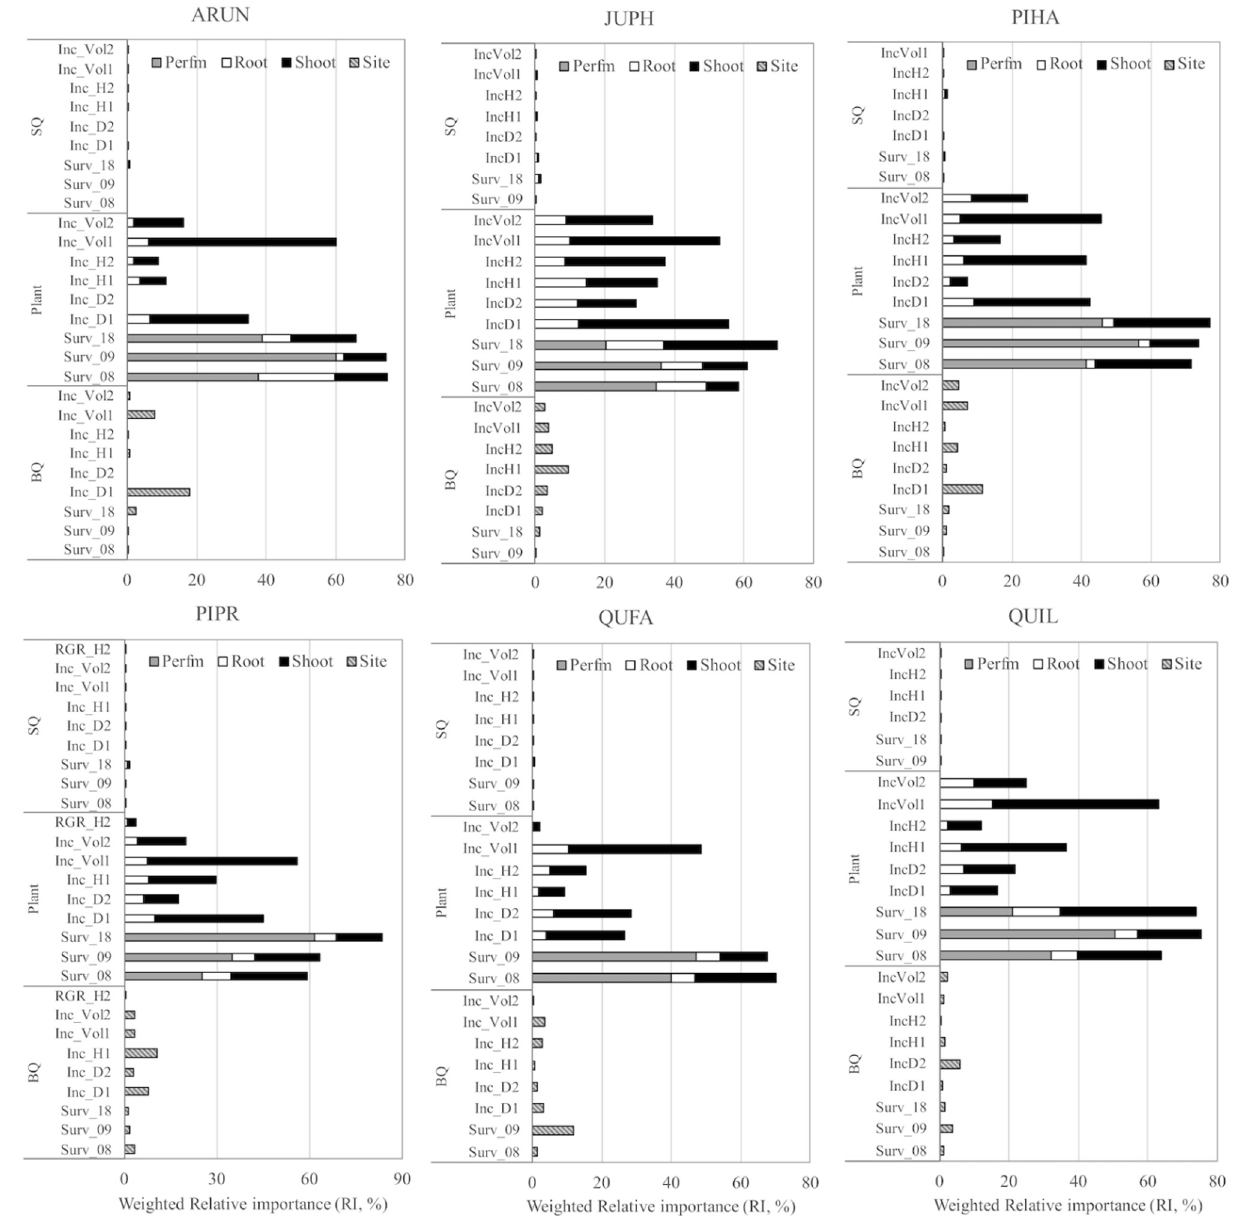
Figure 5. Relative importance (RI, %, obtained from BRT models) for the different sets of traits and independent variables on both plantation survival (2008, 2009, and 2018) and early growth traits (increments in diameter, D, height, H, and volume, Vol, in the first growing season, 1, and in the first summer, 2). The sets of predictors for survival are site (or experimental block, BQ), the quality attributes of the stocklot (SQ), and the individual plant traits (grouped in shoot, root, and early growth performance). For the early growth response, the sets are BQ, SQ, and individual plant traits grouped in shoot and root. RI was weighted by the cv ROC score (survival) or the cv correlation (early growth traits). Partial dependence plots for the most influential independent variables are presented in Figures 6 and 7, and Supplementary Figures S2 and S3. Codes of the species are shown in Table 1. In PIPR, the monthly relative growth rate (RGR) for height growth in summer was used instead of the net increment as no model could fit in the latter. In QUFA, no model was fit for survival at the mid-term due to total mortality in one stocklot (coefficient estimates were inflated).